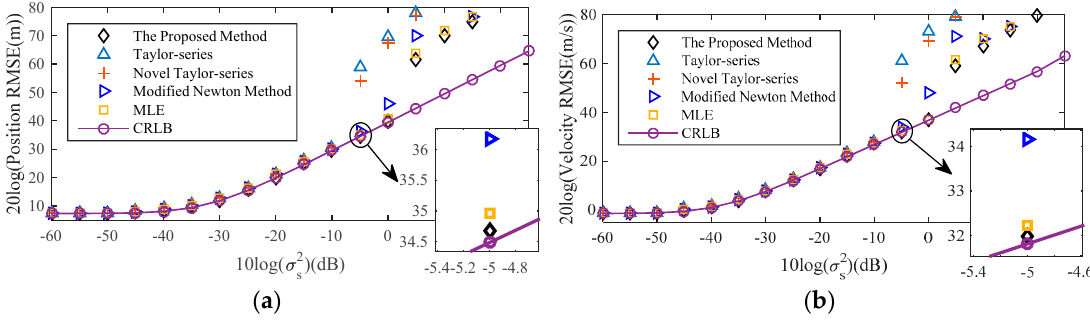
Figure 11. RMSE Comparison among different methods for the near-field source. ( a ) Position RMSE;